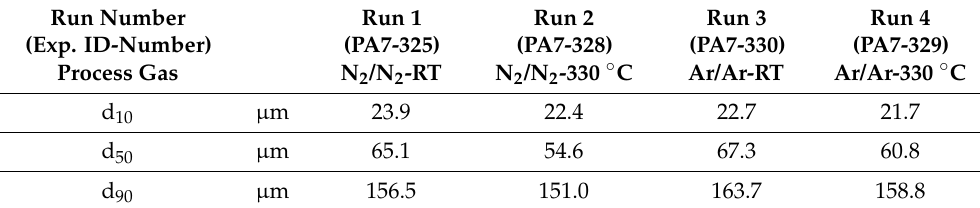
Table 5. Particle size parameters of the powder fraction < 200 µ m.